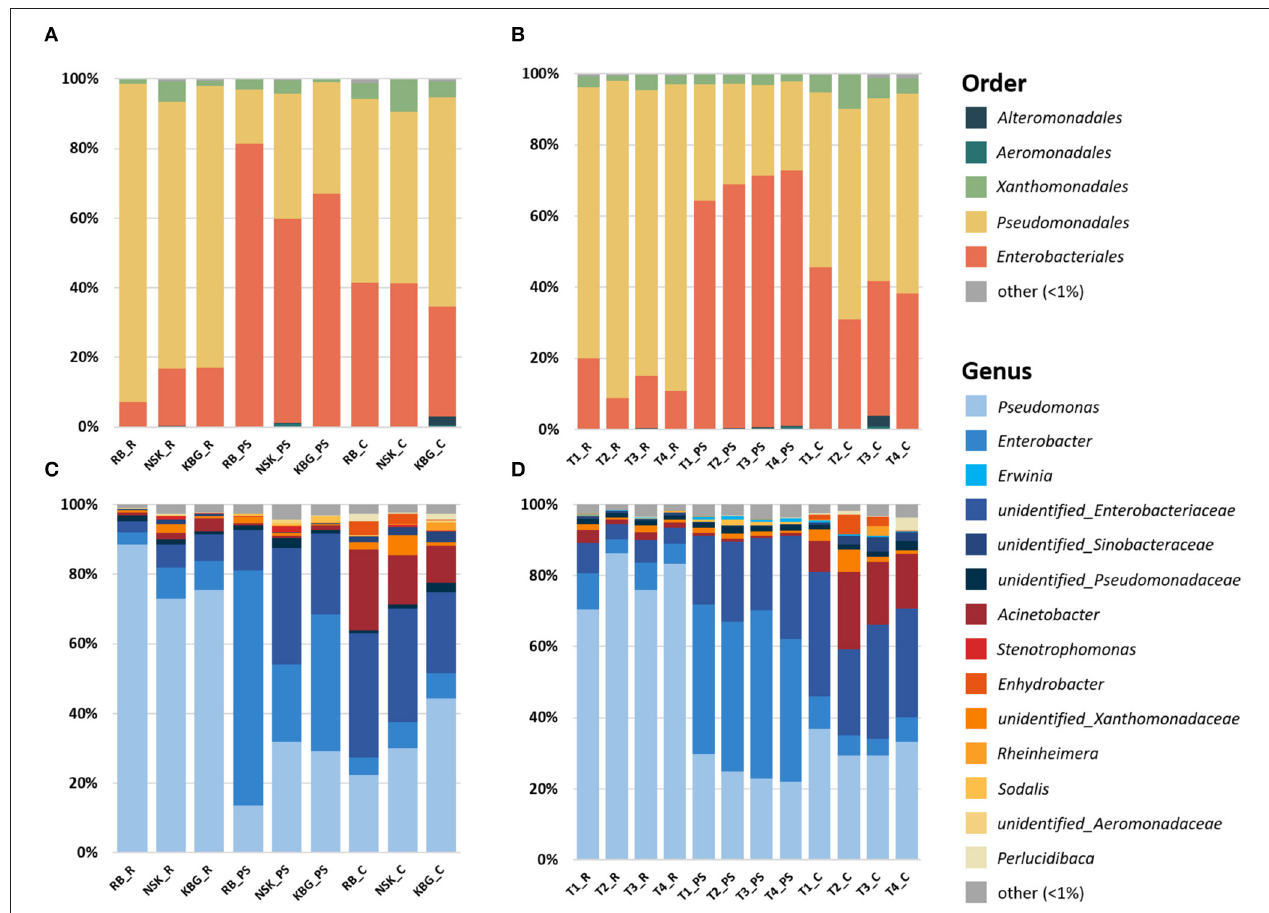
FIGURE 3 | Taxonomic composition of Gammaproteobacteria communities inhabiting rhizosphere, pseudostem endosphere, and carposphere of banana plants grown at three smallholder farms in Uganda under varying organic management regimes. Sequences were classified at order (A,B) and genus (C,D) levels. Groups were encoded using abbreviations indicating: (1) farm (RB, NSK, KBG), (2) microenvironment (R, rhizosphere, PS, pseudostem endosphere, C, carposphere), and (3) organic matter input (T1 = mulch, T2 = mulch + manure, T3 = manure, T4 =